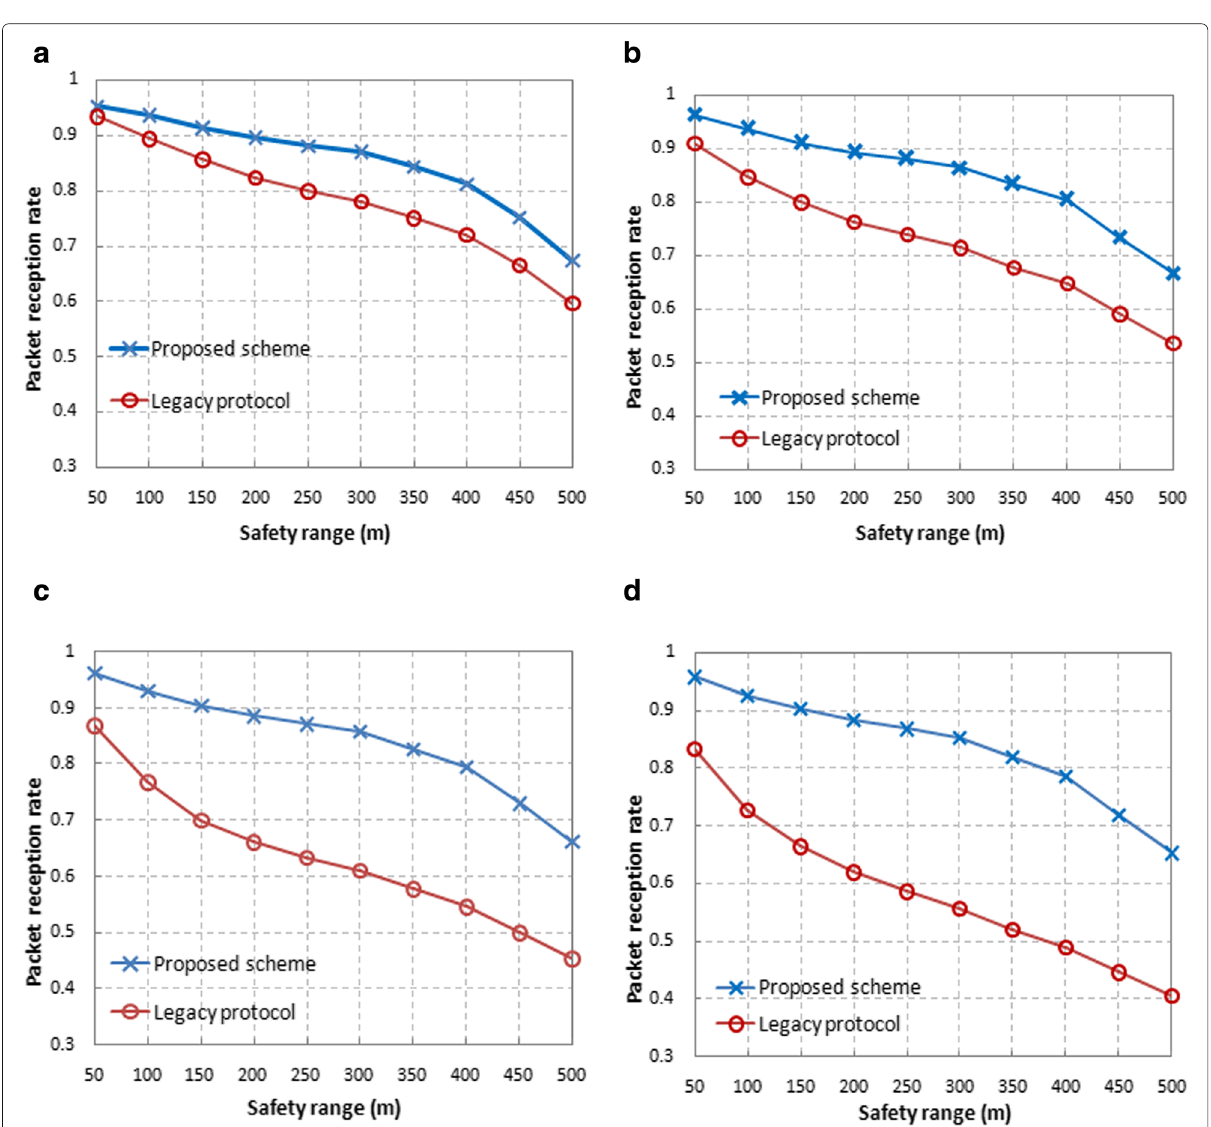
Fig. 3 a – d Packet reception rates. a 40-node network, b 60-node network, c 80-node network, d 100-node